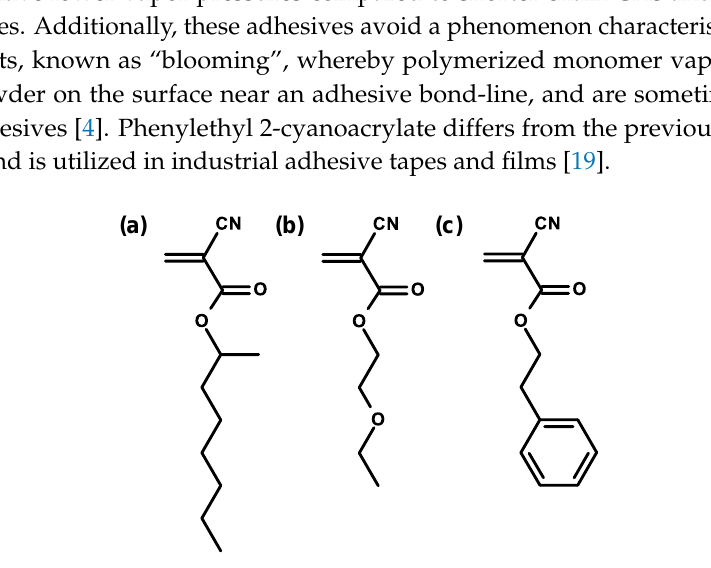
Figure 1. ( a ) 2-octyl ( b ) β -ethoxyethyl ( c ) phenylethyl 2-cyanoacrylates.